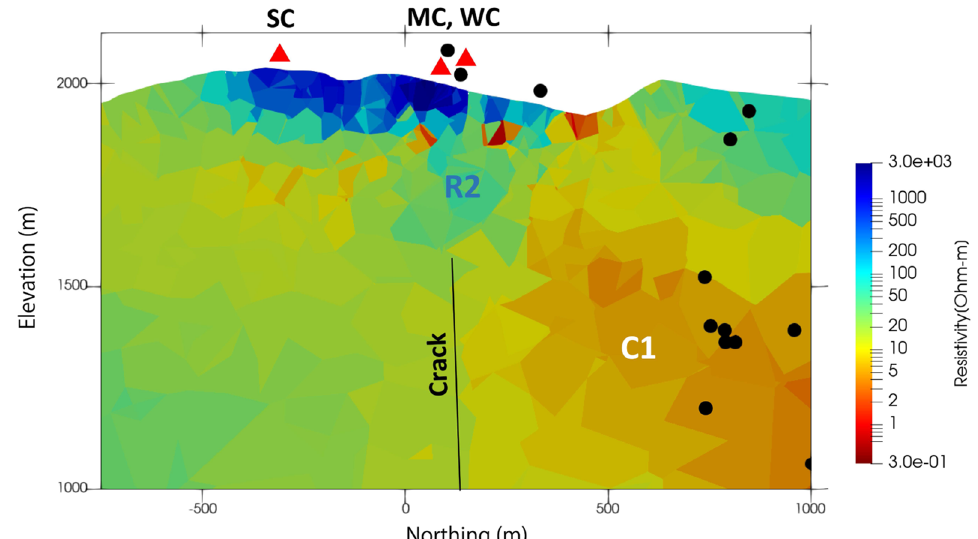
Fig. 9 Source locations of the volcanic tremors and a crack model related to the 2018 eruption shown on the north–south cross-section of the 3-D resistivity model. The red triangle represents the main crater of the 2018 eruption (MC). Black dots represent volcanic tremors just before the 2018 eruption, as suggested by Yamada et al. (2021). The black line represents the crack model indicated by Terada et al.